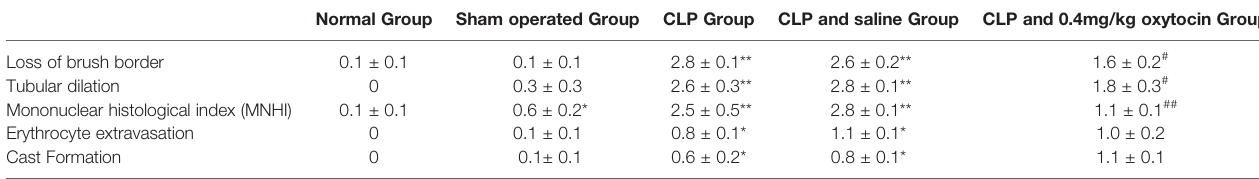
TABLE 1 | Results from studies by C ̧ avus ̧ og ̆ lu et al. comparing the effects of oxytocin in CLP